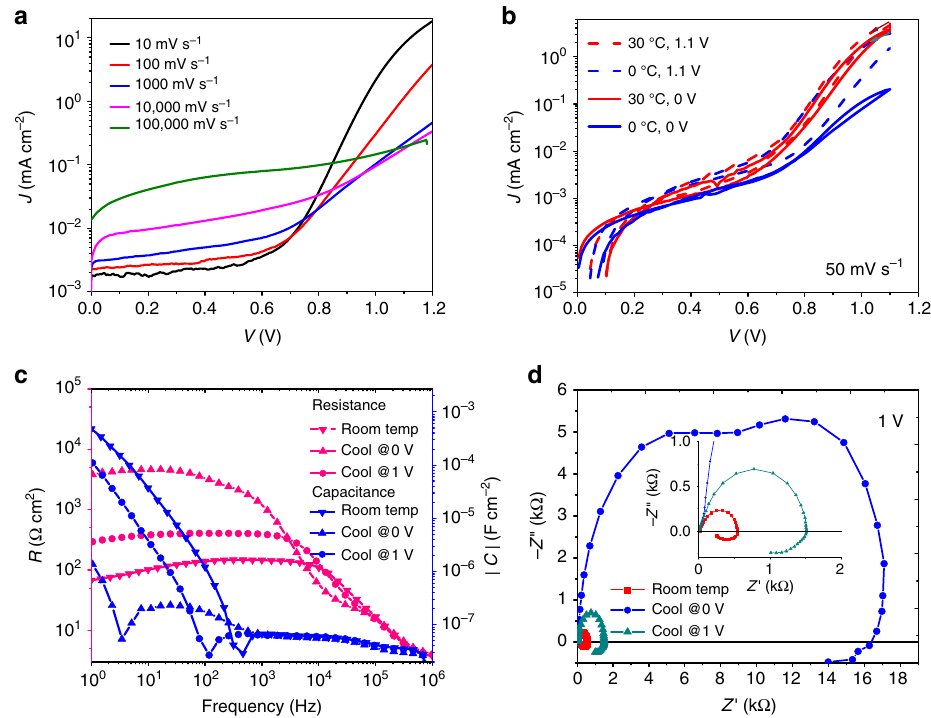
Fig. 7 JV curves for negative-capacitance device. a Logarithmic representation of the forward scan (0 – 1.2 V) of Fig. 5a, indicating an increased series resistance for faster scans. b JV curves (50 mV s − 1 ) measured after equilibration at 0 V (solid) and 1.1 V (dashed), at 30 °C (red) and 0 °C (blue), showing a higher series resistance for lower temperatures. c and d EIS data obtained at different temperatures (cool means 0 °C). Cooling-down has been done while keeping the device either at 0 or 1 V to freeze different ion distributions. Cooling down at 0 V induces a higher resistance consistent with the JV